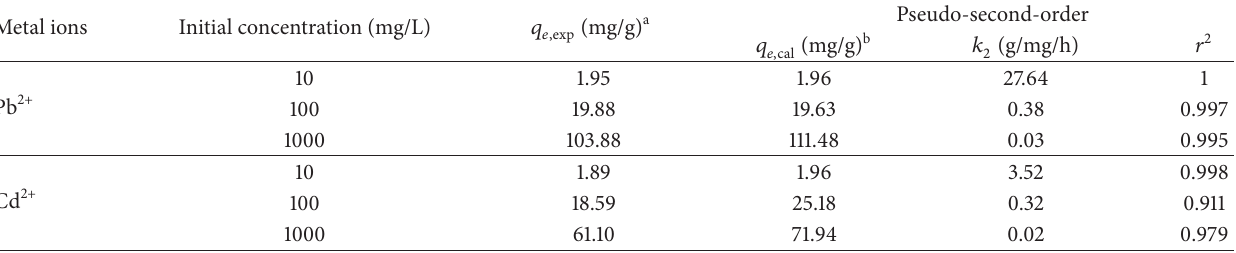
Table 6: Pseudo-second-order kinetic parameters for adsorption of Pb 2+ and Cd 2+ on 10/90 HAp/chitosan hybrid fiber. Metal ions